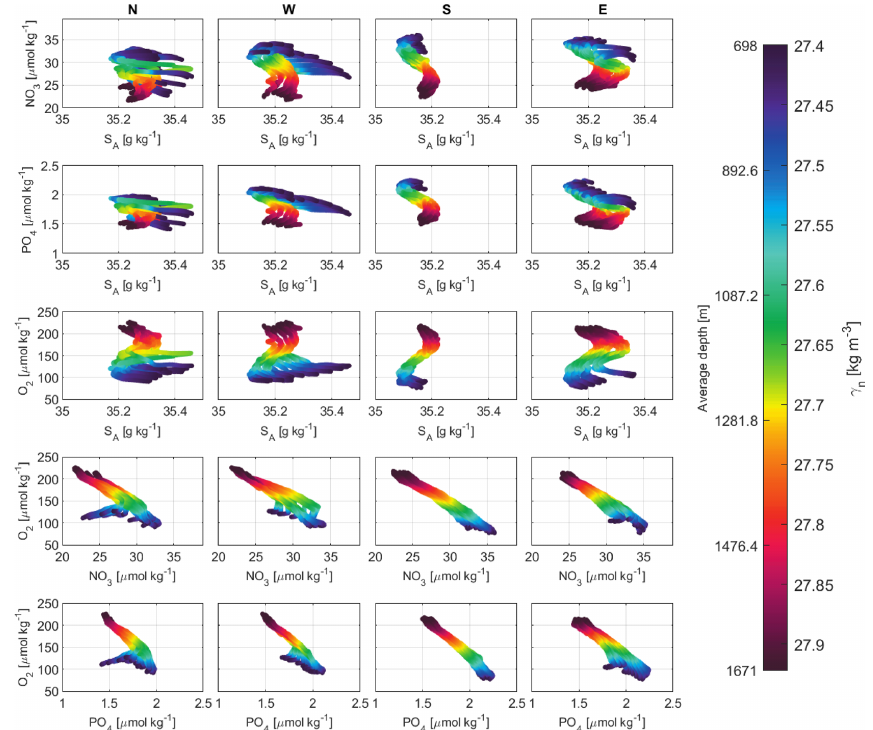
Figure 9. Scatterplots of in situ observations of NO 3 (first row), PO 4 (second row) and O 2 (third row) (in µmolkg − 1 ) with respect to S A and γ n (in color with an approximate scale of the average depths) in the north (N, first column), west (W, second column), south (S, third column) and east (E, fourth column) transects for IW layers. In the fourth and fifth rows, scatterplots of NO 3 –O 2 and PO 4 –O 2 in four transects for the IW layers are shown.